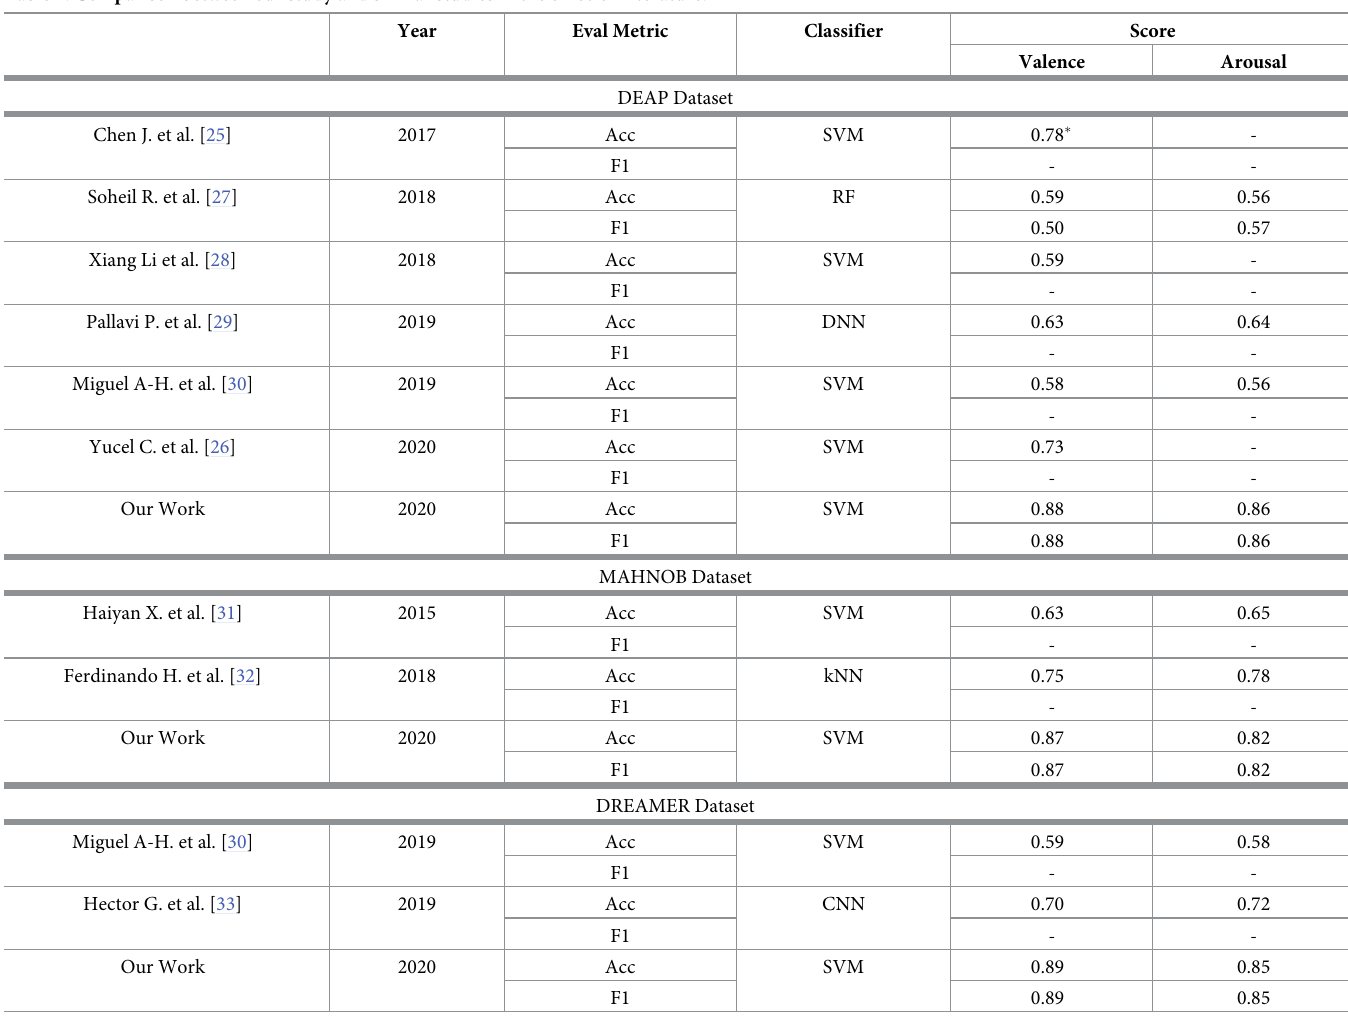
Table 1. Comparison between our study and similar studies in the emotion